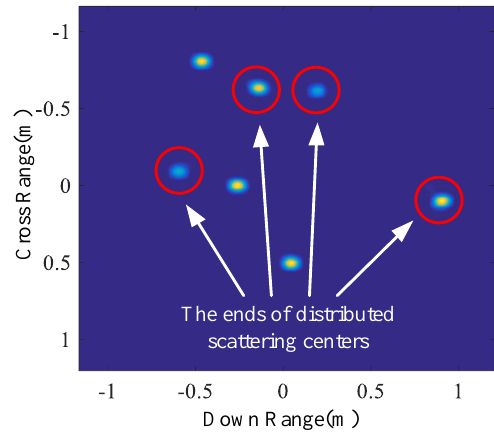
Figure 11. The original imaging result.